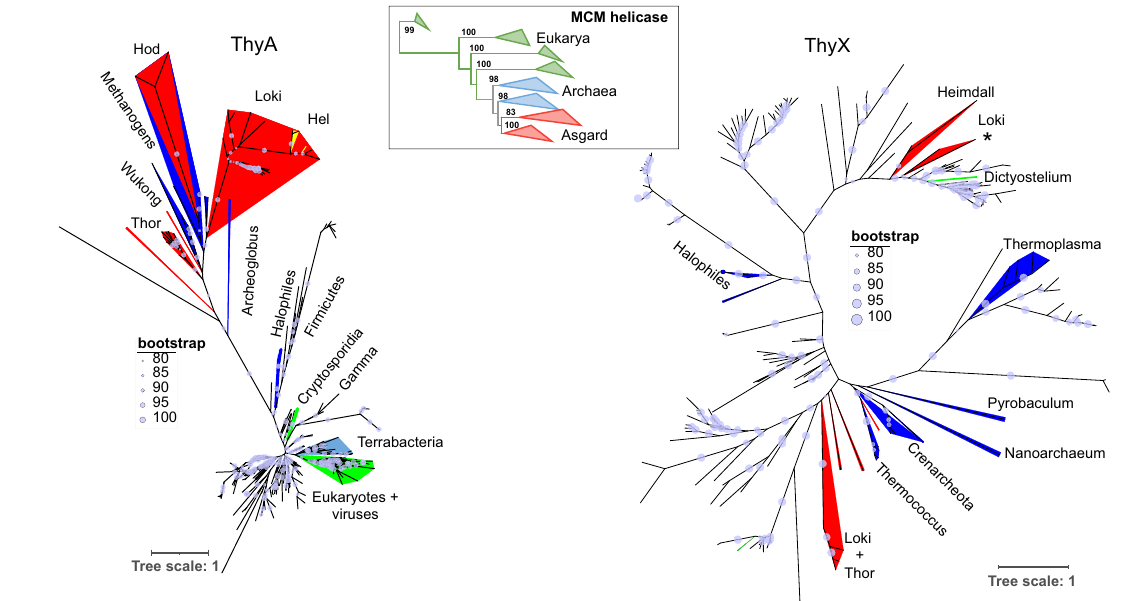
Fig. 4 | Unrooted maximum likelihood phylogenetic tree of ThyX (198 sequences, alignment of 157 amino acids with the LG+G+I phylogenetic model) and ThyA (390 sequences, alignment of121 amino acids withthe LG+G +I model) with a focus on Asgard proteins. The obtained ThyX tree indicates multiplelateralgenetransfersfrombacteriato Psyn andotherAsgardgenomes.By contrast, the ThyA tree refutes the occurrence of recent and multiple lateral gene transfersfrom bacteriatoAsgardgenomes.Asgardsequences are indicated inred,